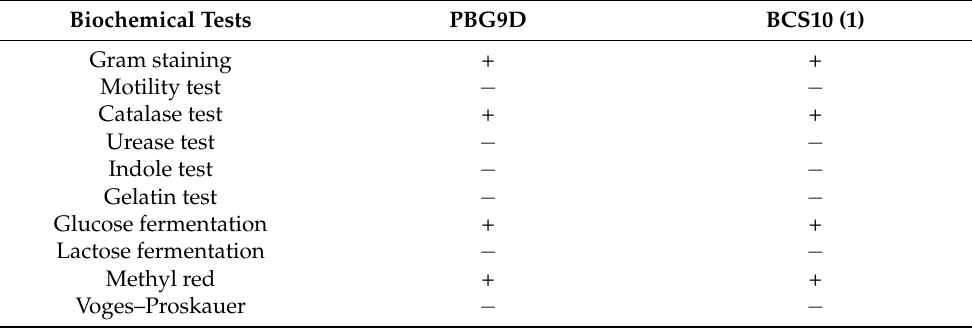
Table 4. Biochemical characterization of bacterial strains isolated from fish gut.